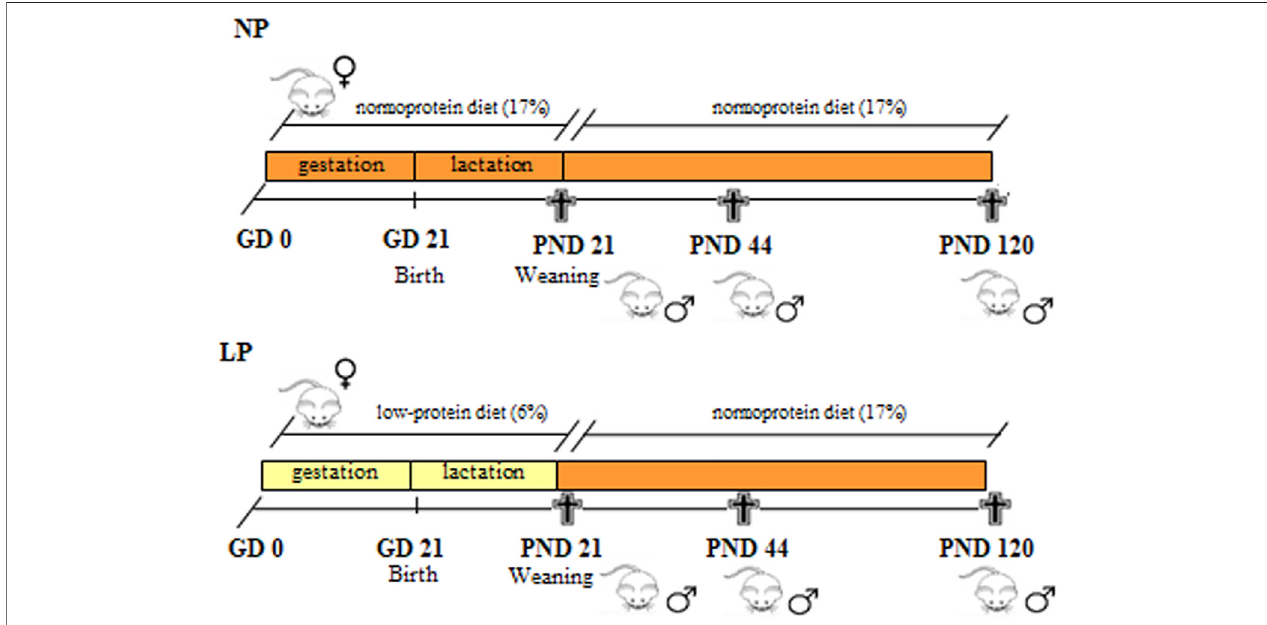
FIGURE 1 | Experimental design. Pregnant rats received a low-protein diet (LP group) or a normal-protein diet (NP group) ad libitum from the GD 0 until PND 21 (during gestation and lactation). After weaning, male pups from both groups received a standard diet until PNDs 21, 44 and 120.